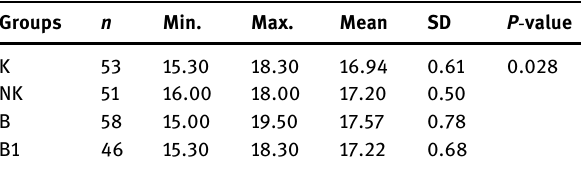
Table 3: Comparison of groups in terms of chick length Groups